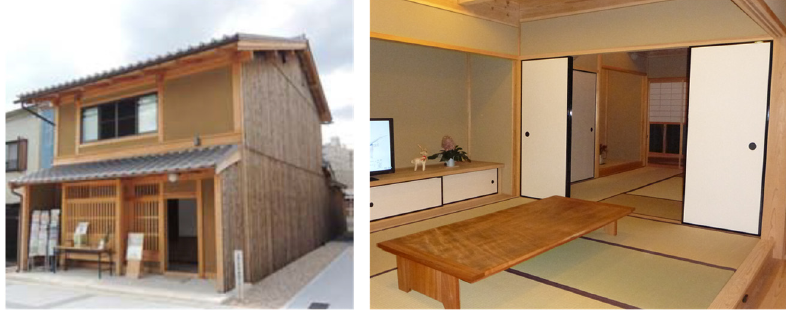
Figure 5. Outer and inner appearances of the “Heisei-no-Kyo-machiya” model.